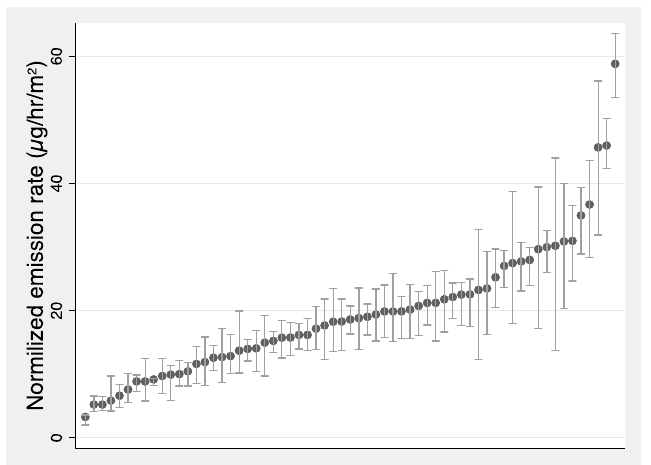
Figure 4. Distribution of weekly averaged formaldehyde emission rate (marker) normalized by floor area; shading area presents the 25th and 75th of the hourly normalized emission rate for each home, x -axis rank ordered by average normalized emission rate.